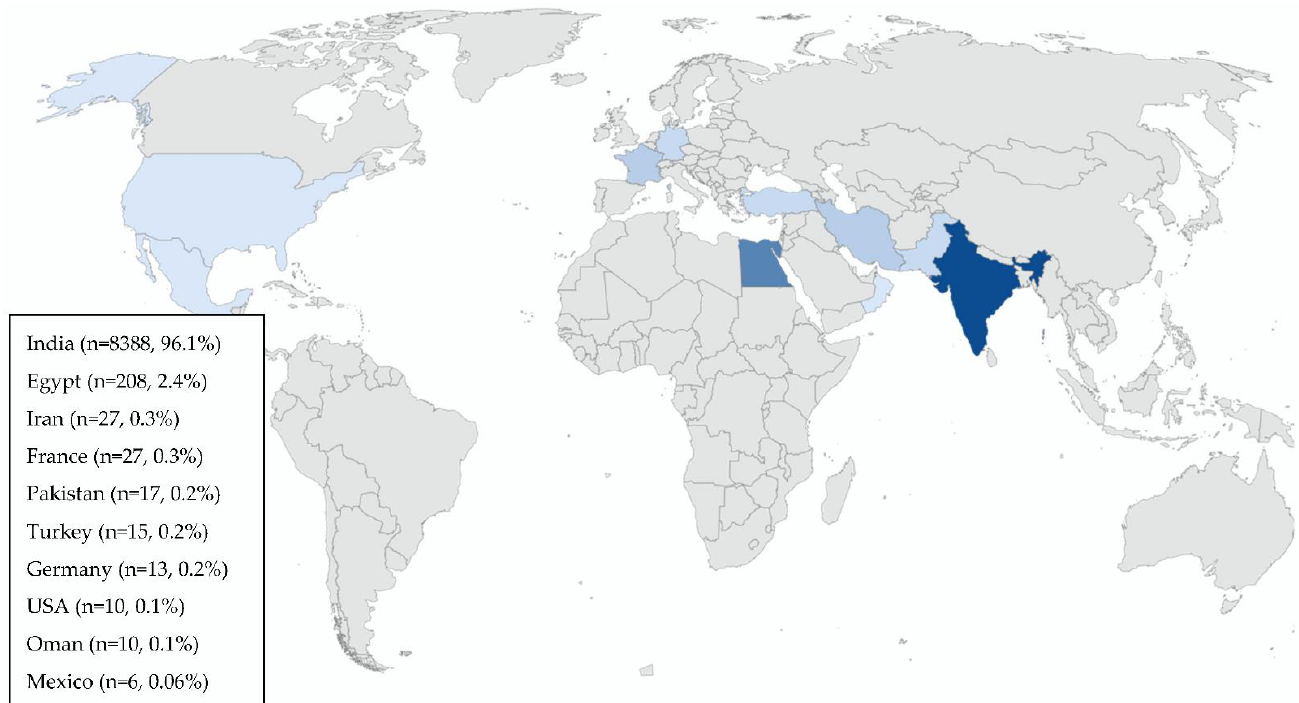
Figure 2. Geographical distribution of patients with COVID-19-associated mucormycosis (CAM) (n, %) reported in the 88 studies included.